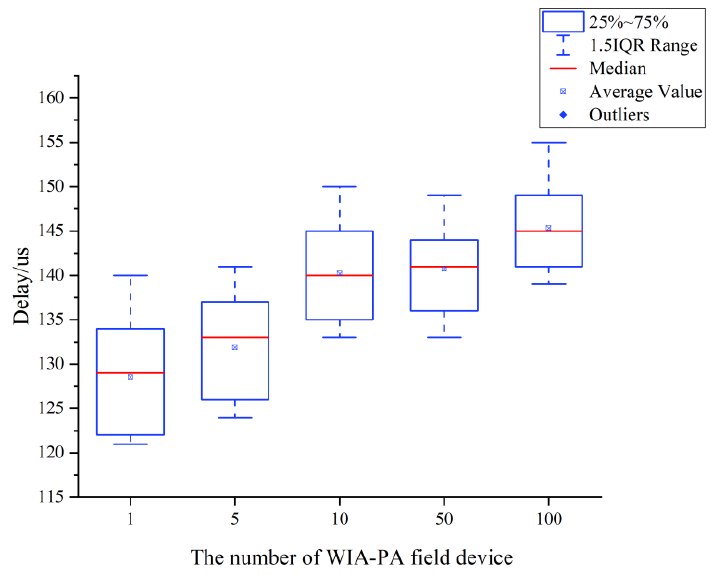
Figure 15. Joint publishing delay of WIA-PA field devices.